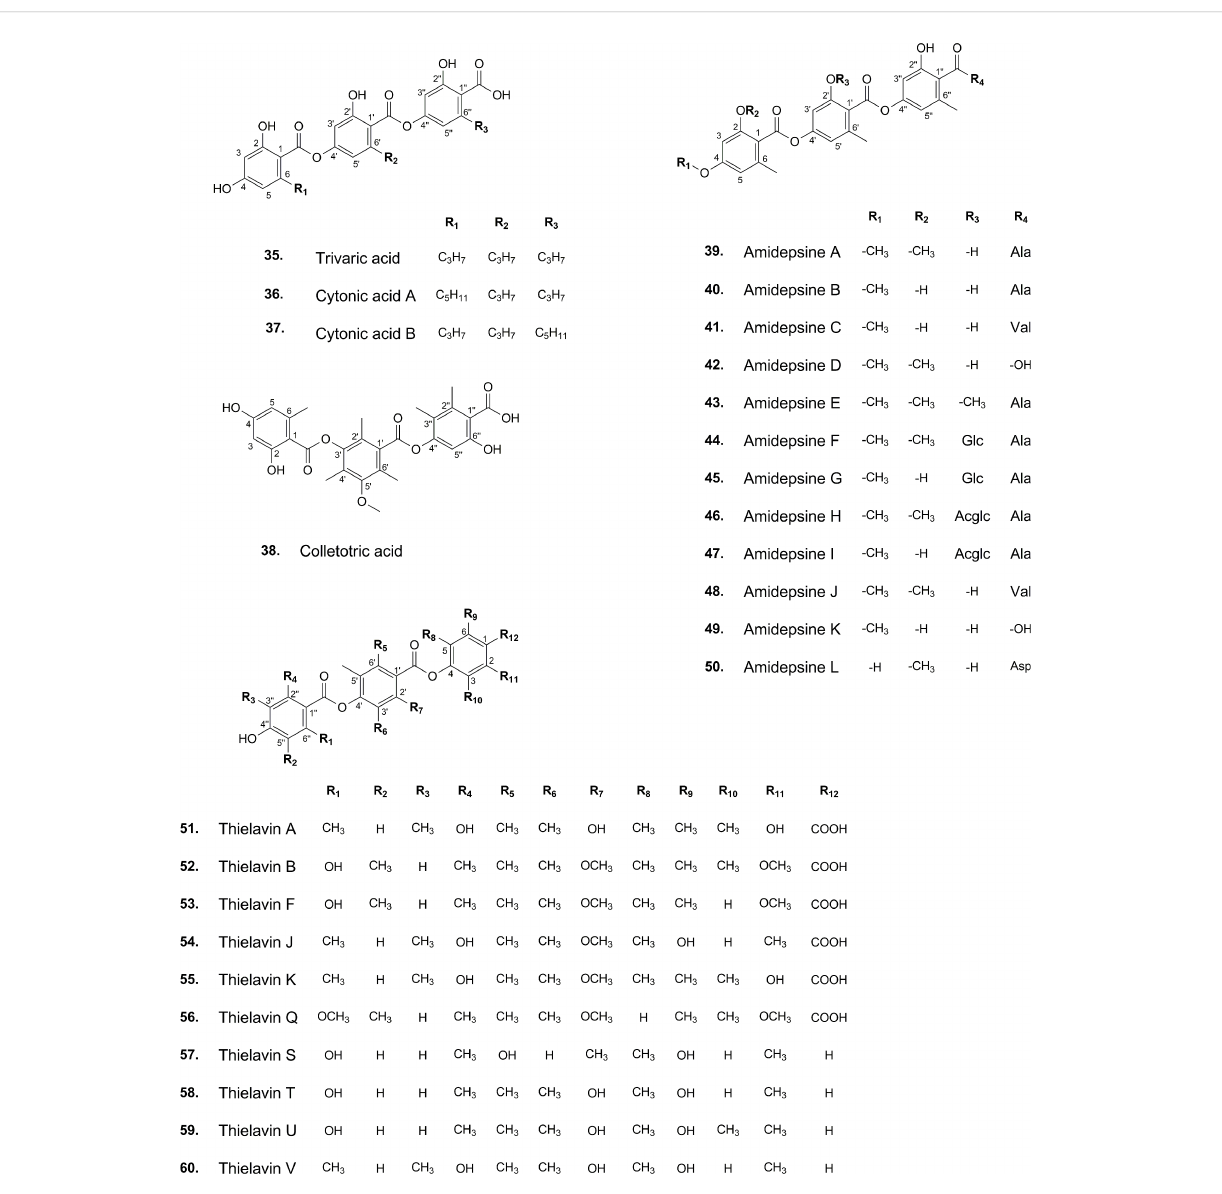
FIGURE 7 Chemical structures of reported non-lichenic